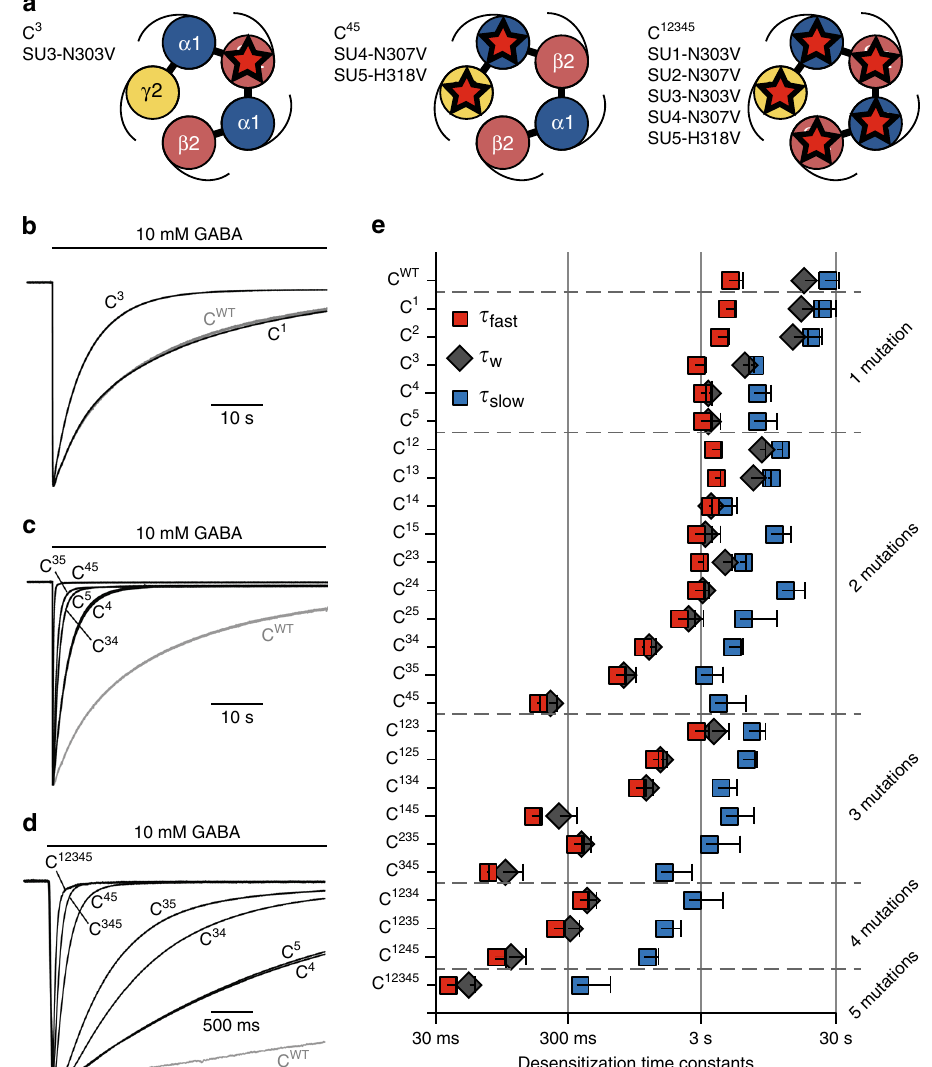
Fig. 2 Desensitization kinetics of α 1 β 2 γ 2 concatemers harboring combinations of M3-5 ′ valine mutations. a Schematic top views of the C 3 (left), C 45 (middle) and C 12345 (right) concatemers. b – d Representative TEVC recording of Xenopus laevis oocytes expressing the indicated concatemers. Note the change in timescale for recordings in panel ( d ). e Plot indicating the mean values for fast (red squares), slow (blue squares), and weighted (dark gray diamonds) desensitization time constants for the indicated concatemers. Error bars are standard deviations. See Supplementary Fig. 1 for individual data points and Supplementary Table 1 for numerical values, the number of cells, and number of independent series of